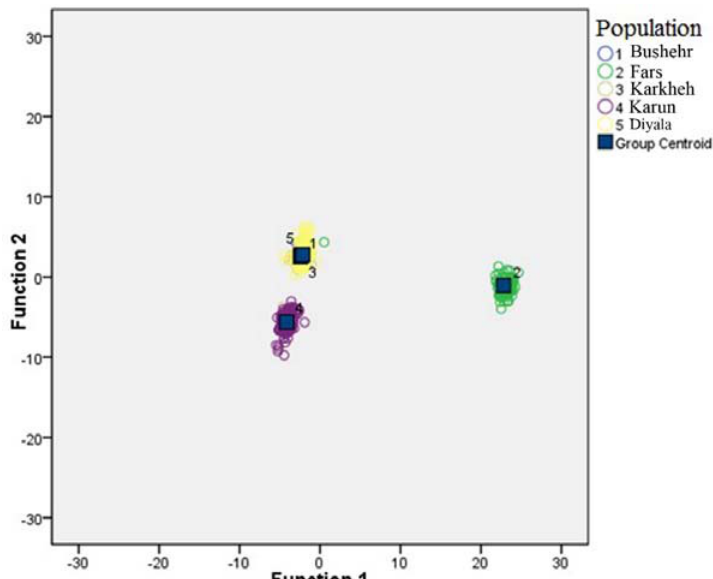
F IGURE 3. Coordinate plot of A. mossulensis from the five basins of Iran according to the first two discriminant functions from morphometric data